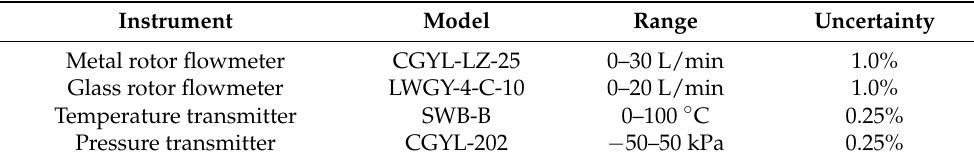
Table 3. Instrument parameters.